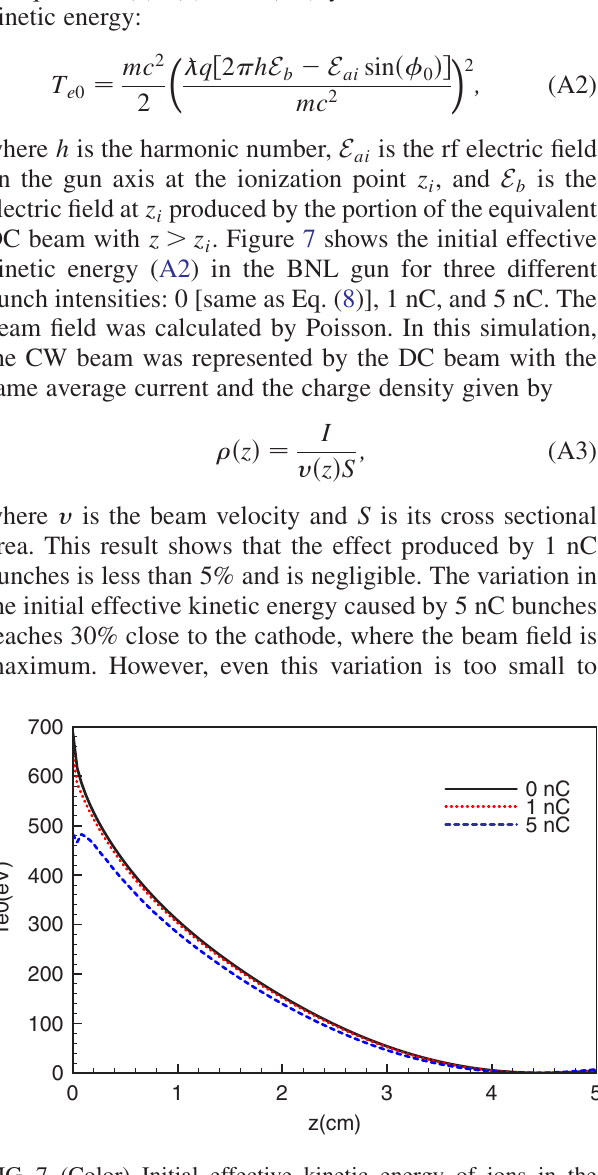
FIG. 7. (Color) Initial effective kinetic energy of ions in the BNL gun for three different beam bunch intensities: 0, 1, and 5